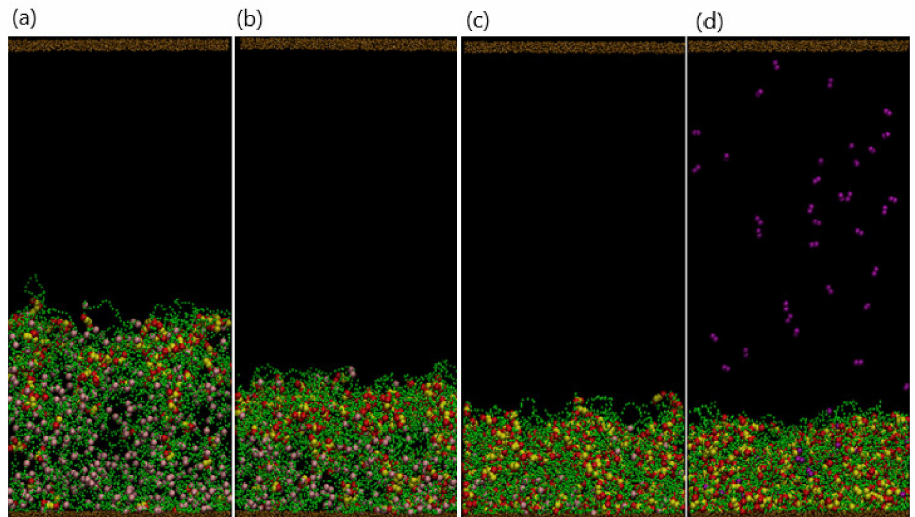
Figure 2. ( a – d )Snapshotsofsystematfinalstage( t = 5 × 10 6 for N dimer